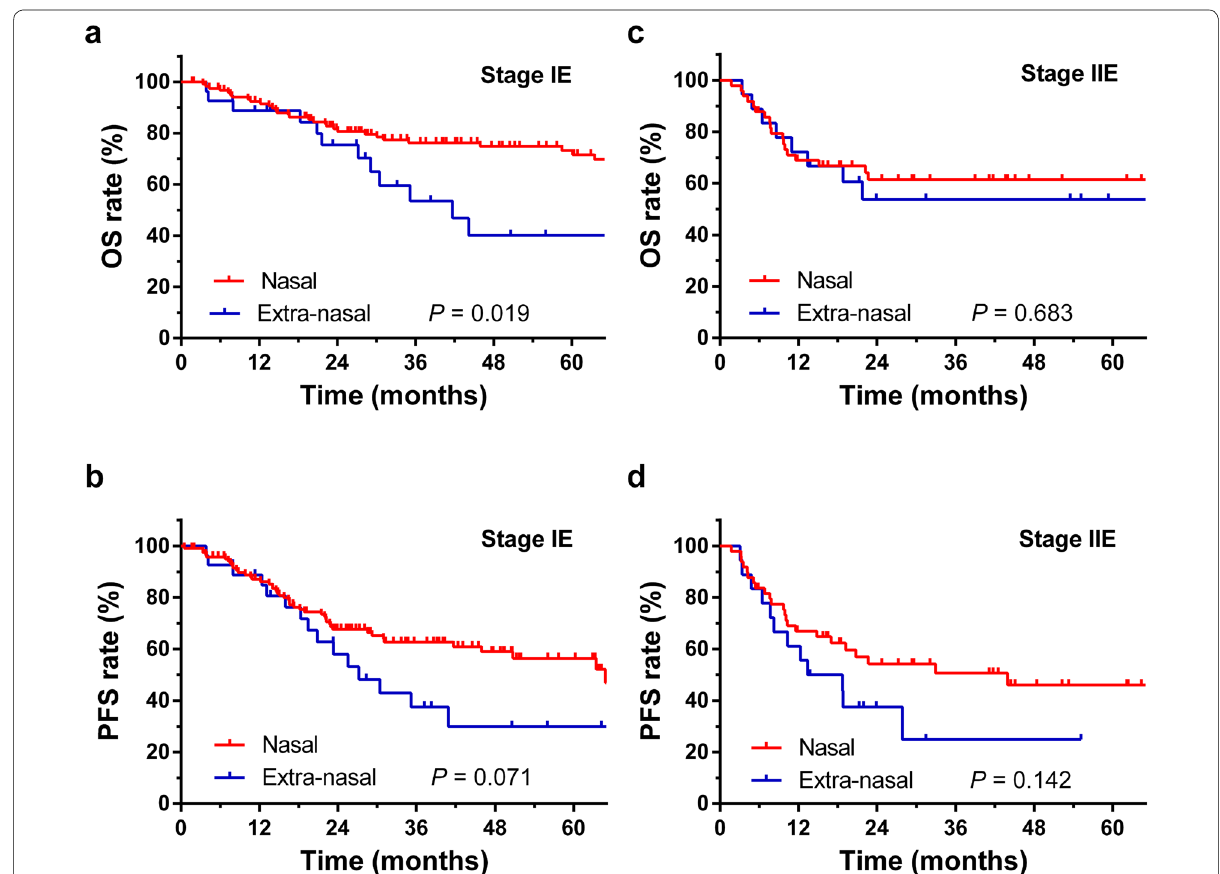
Fig. 3 Survival curves for patients with nasal and extra‑nasal ENKTCL at Ann Arbor stage IE and IIE. a OS for patients with nasal and extra‑nasal disease at Ann Arbor stage IE; b PFS for patients with nasal and extra‑nasal disease at Ann Arbor stage IE; c OS for patients with nasal and extra‑nasal disease at Ann Arbor stage IIE; d PFS for patients with nasal and extra‑nasal disease at Ann Arbor stage IIE